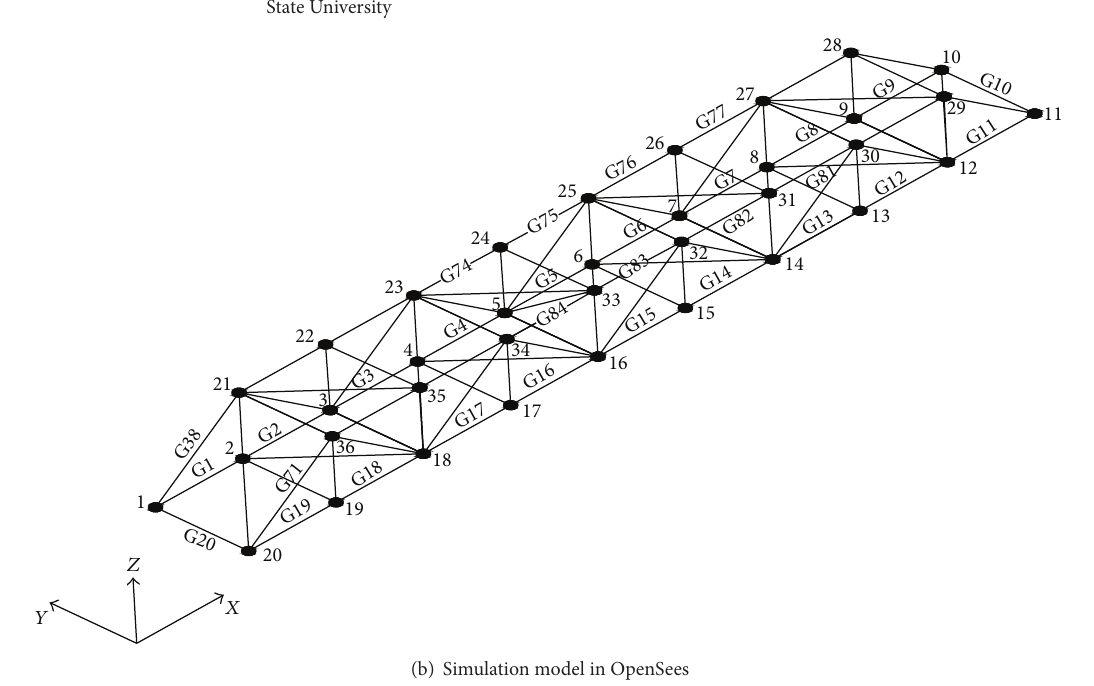
Figure 1: Simulation model of three-dimensional prototype steel truss structure.